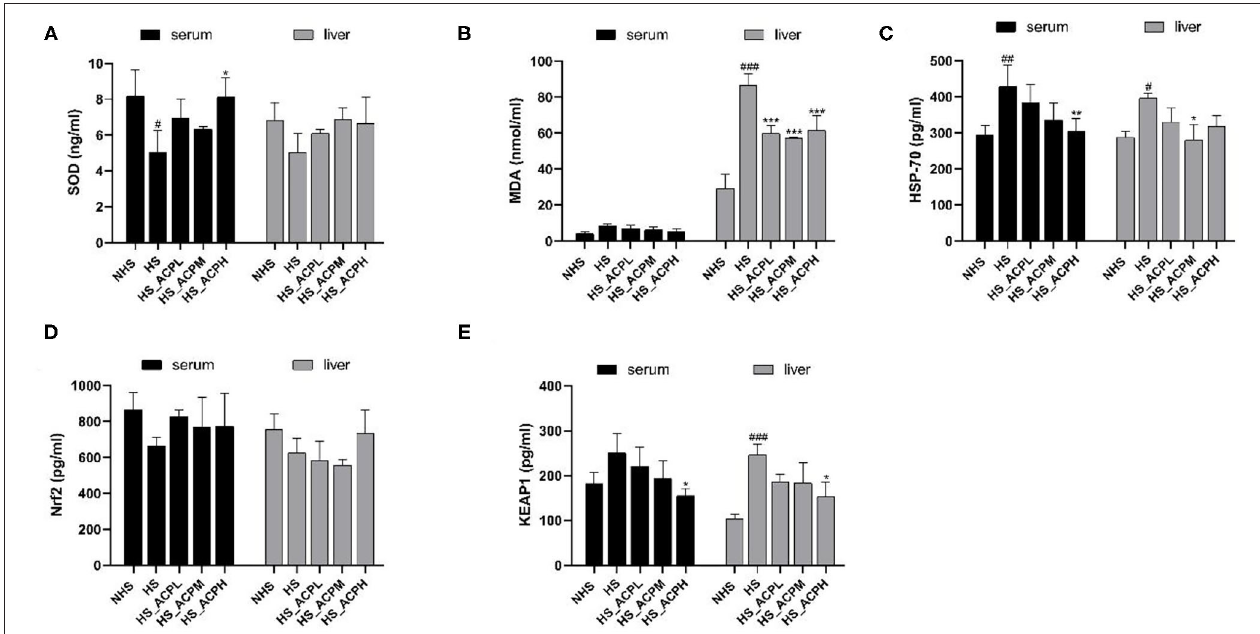
FIGURE 2 | Effects of ACP supplementation on the levels of antioxidants related in serum and liver. (A) superoxide dismutase (SOD), (B) malonaldehyde (MDA), (C) heat shock protein 70 (HSP-70), (D) nuclear factor erythroid-2 related factor 2 (Nrf2), (E) Kelch-like ECH-associated protein 1 (Keap1). Data are presented as the